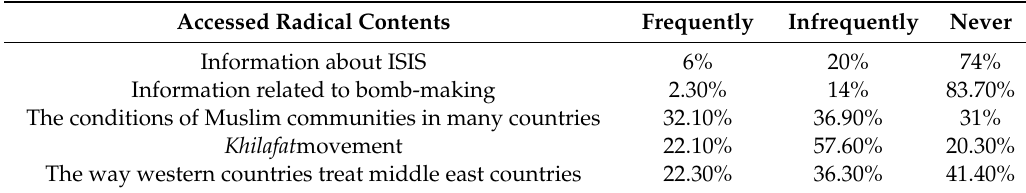
Table 4. Radical Content Accessed by State University